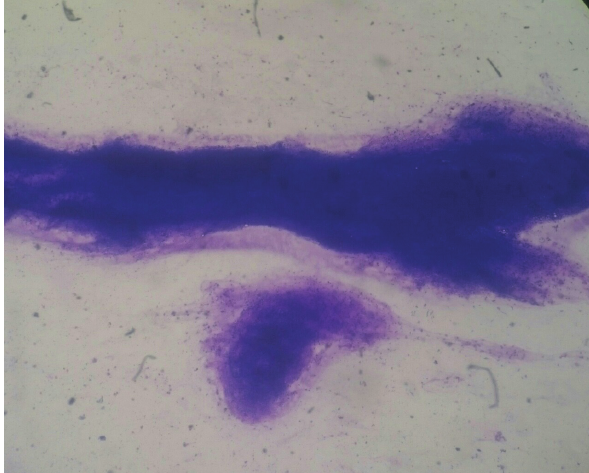
Figure 1A: Squash smear: GBM showing pleomorphic tumor cells in glial background. Occassional bizzare looking cells present and many proliferating capillaries also seen.